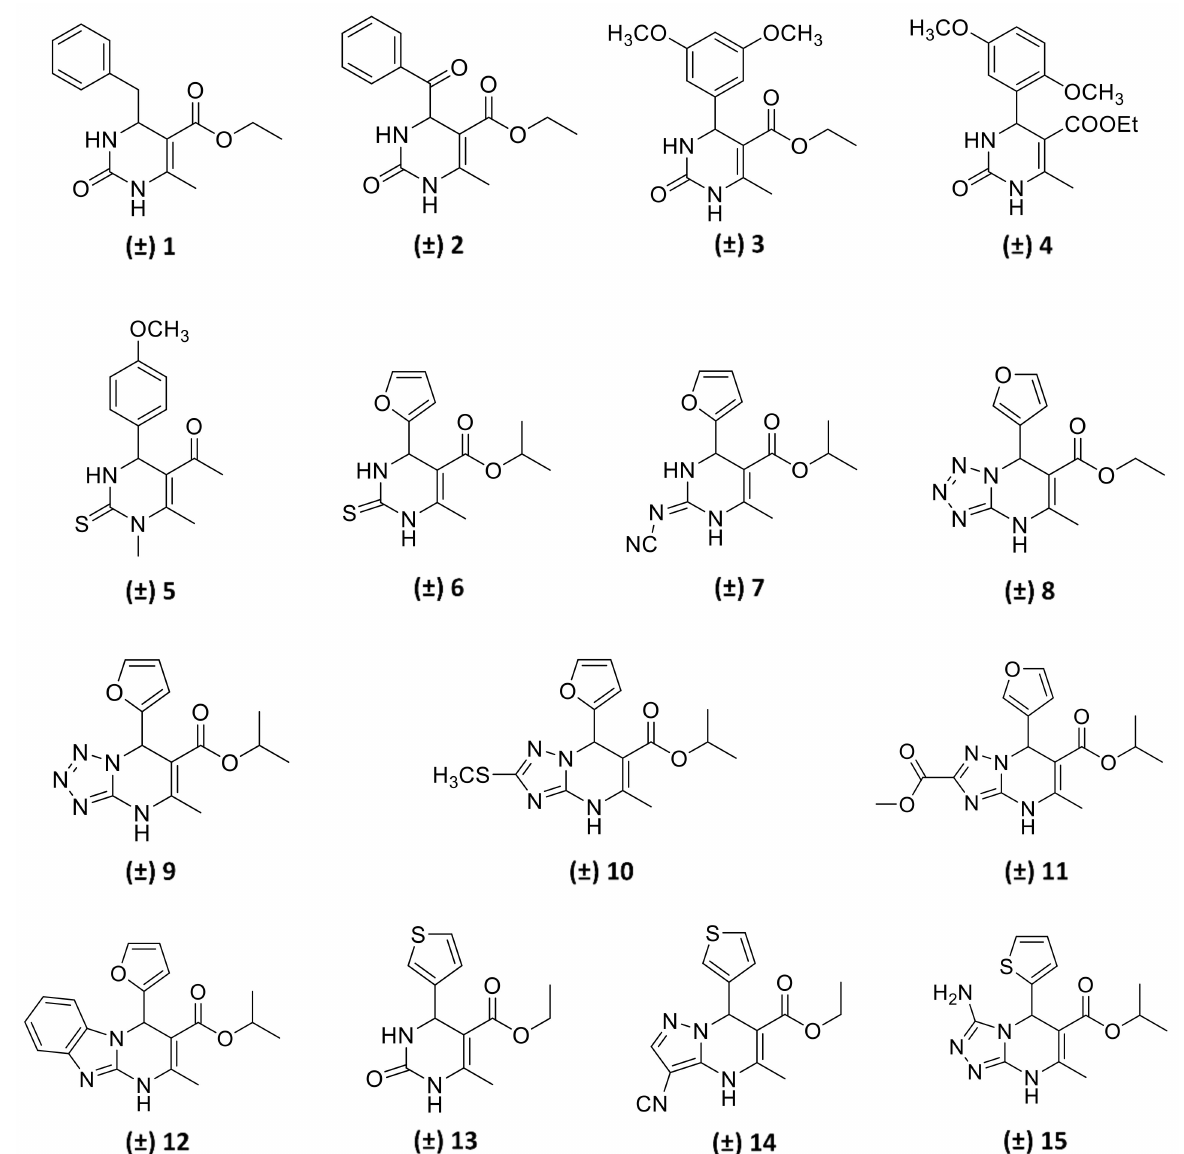
Figure 1. Structures of the examined chiral 4-aryl-substituted 3,4-dihydropyrimidin-2(1 H )-one (DHP) ester derivatives. The biological activity of compounds 8 – 11 and 14 – 15 will be published